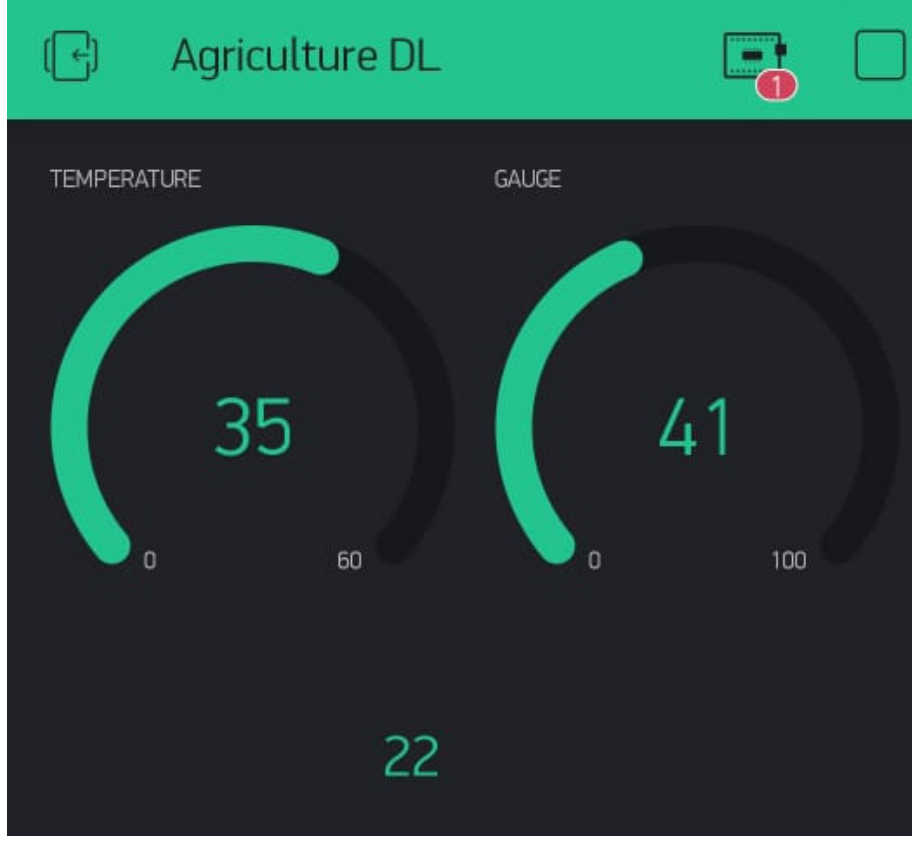
Figure 17. Blynk dashboard. Table 9. Comparison of the LoRa-based agriculture research with the present